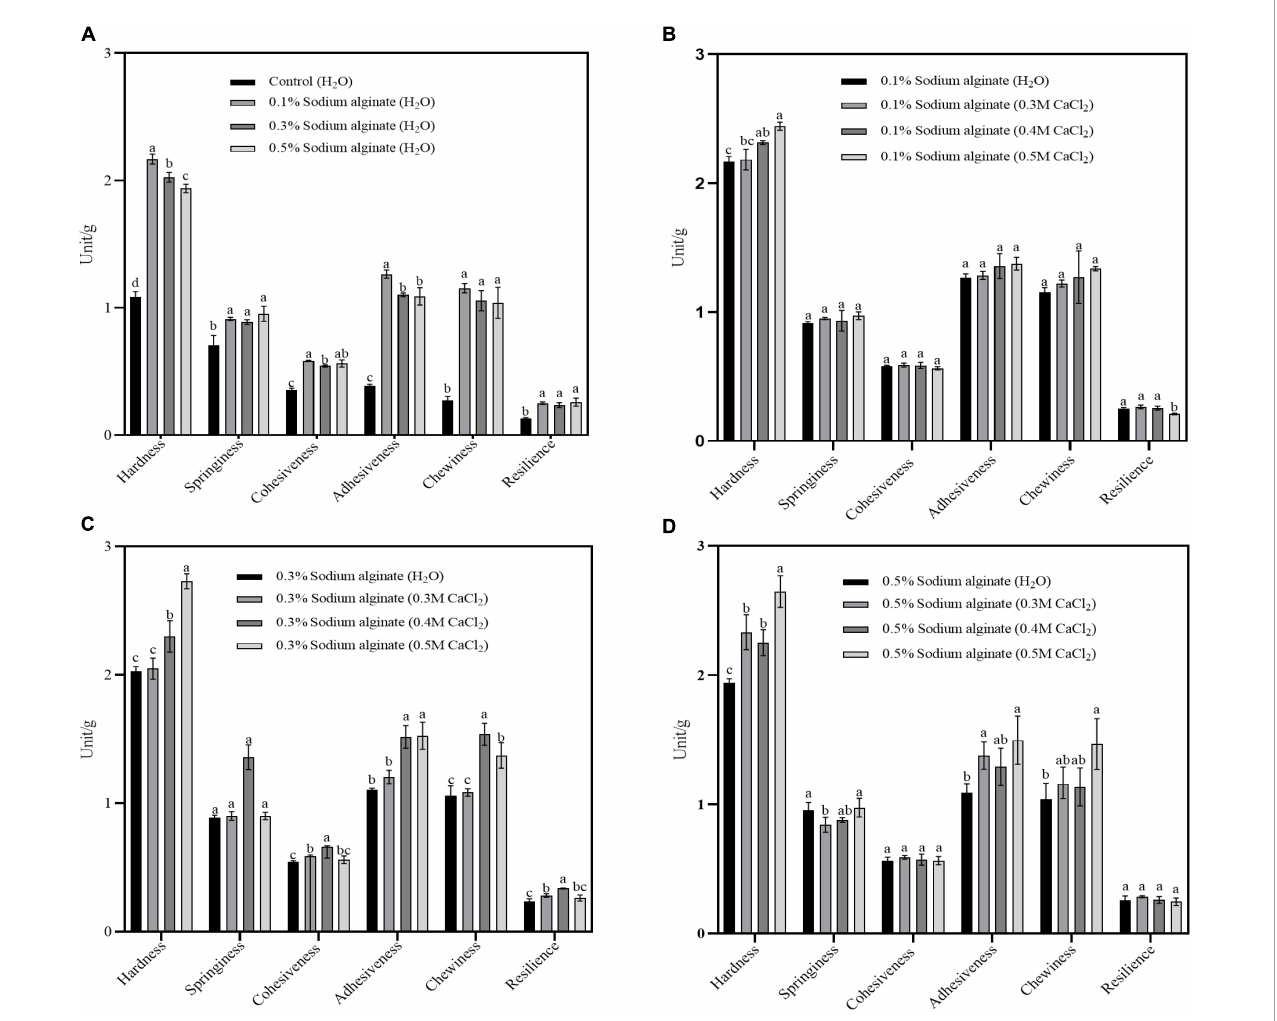
FIGURE1 (A–D) Show the effects of varying Ca 2 + concentrations on the textural properties of buckwheat noodles prepared by the exogenous method. Control group panel (A) was steamed with deionized water. The experimental group in panels (B–D) were steamed with calcium chloride solution of different